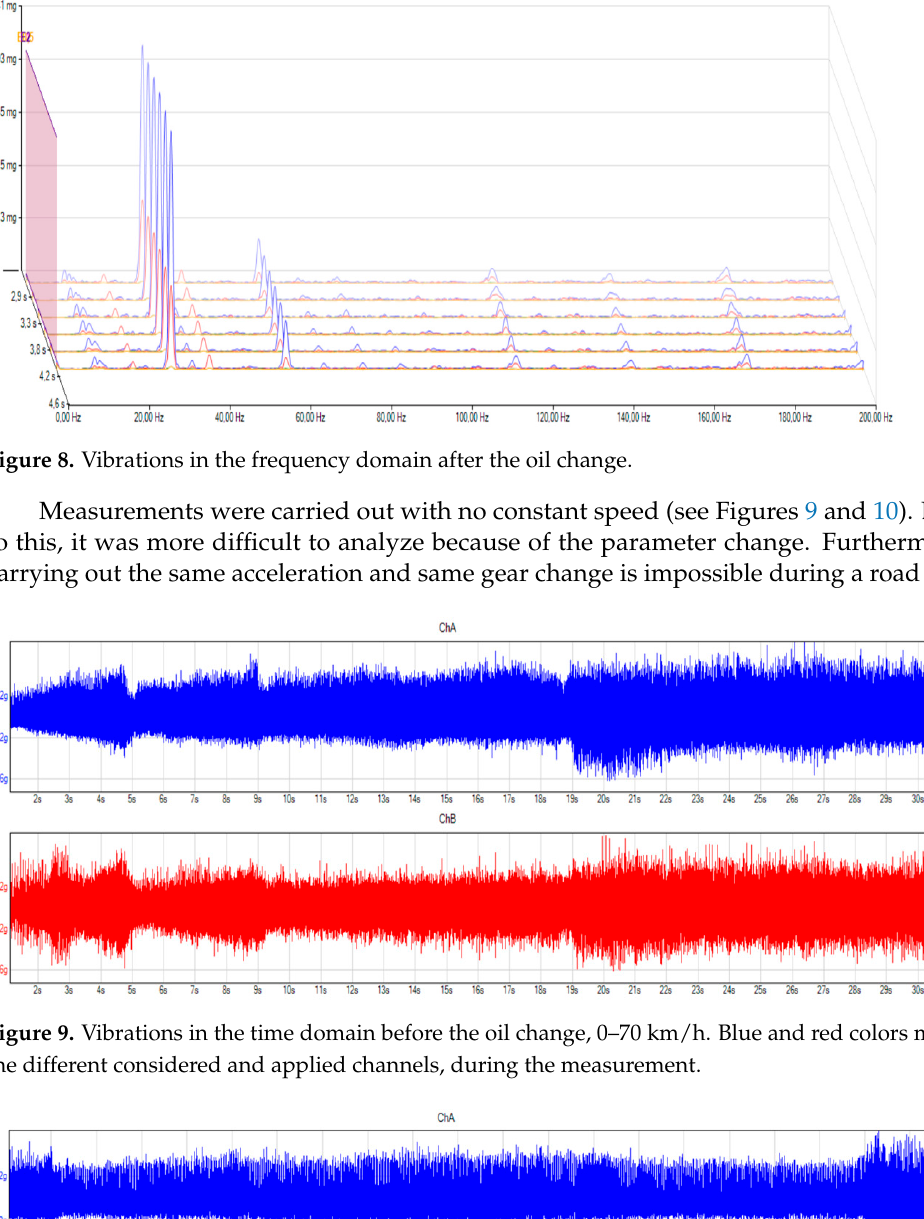
Figure 9. Vibrations in the time domain before the oil change, 0–70 km/h. Blue and red colors mean the different considered and applied channels, during the measurement.